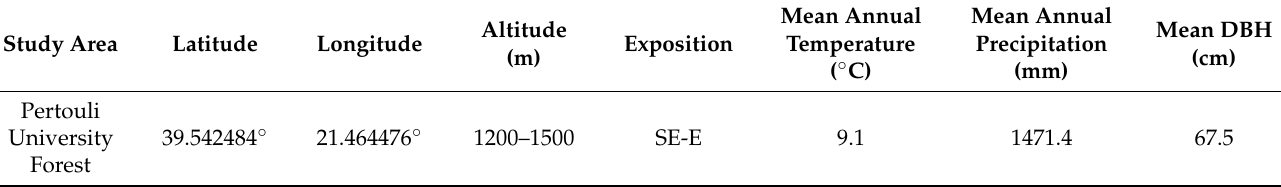
Table 1. Sampling area and site